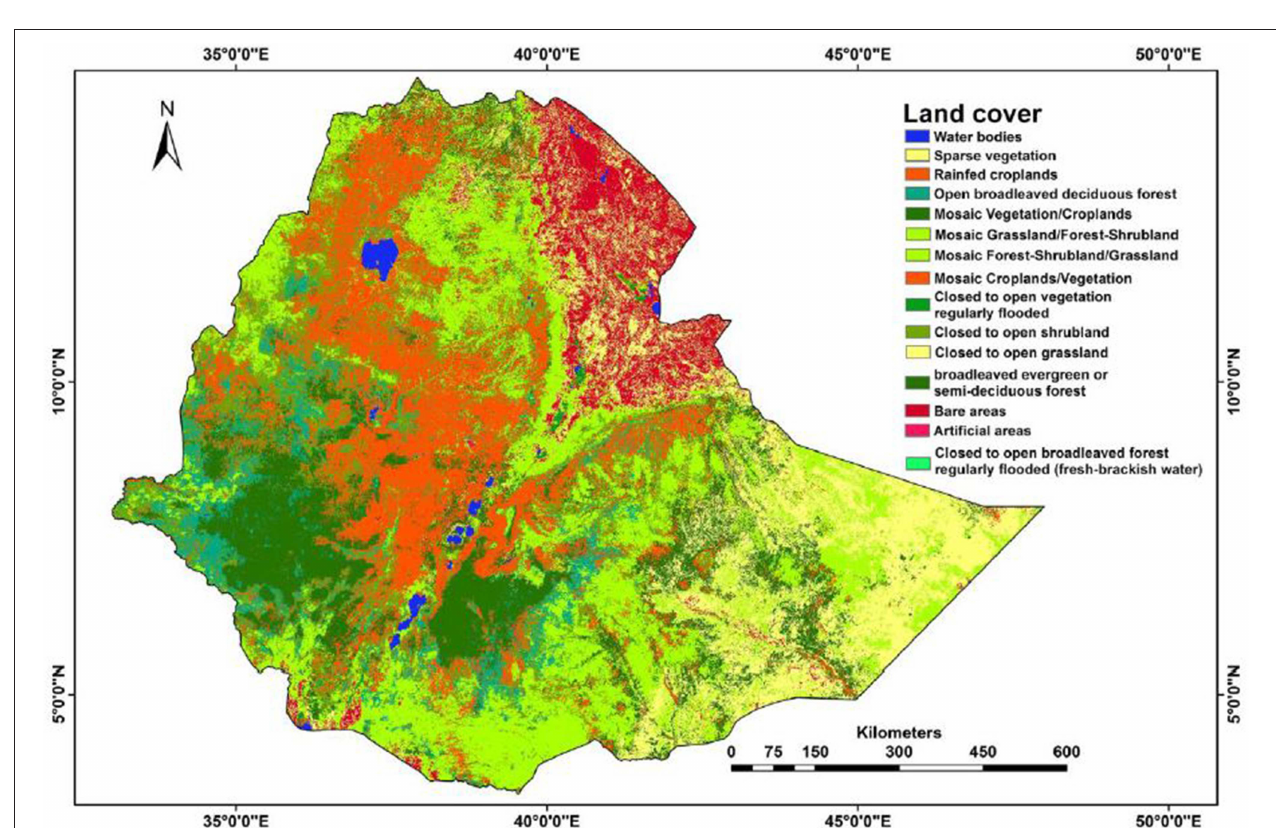
FIGURE 4 | Landcover map of Ethiopia (FAO, 2009 cited in Hailu et al.,